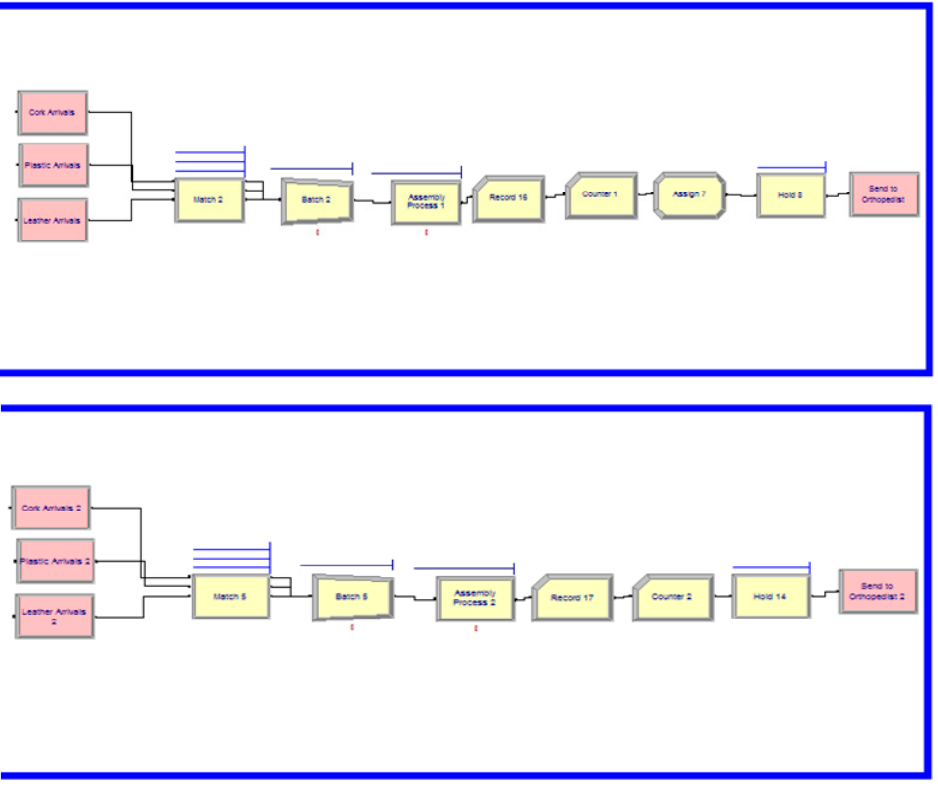
Figure 9. Assembling of cork, plastic and leather in manufacturers.